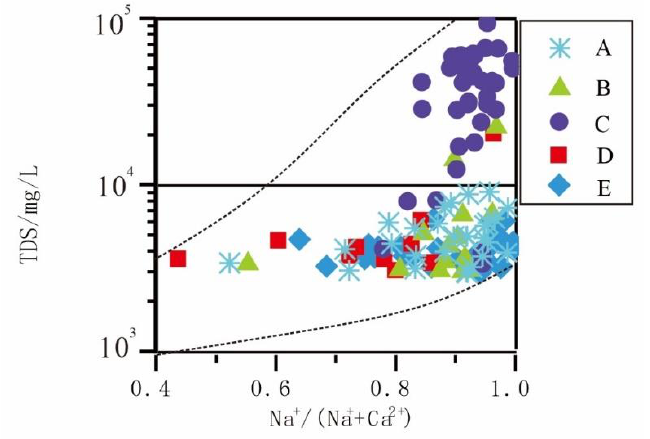
Figure 6. Gibbs diagram of sampling points in different highly mineralized water distribution zones in shallow Hetao Plain.